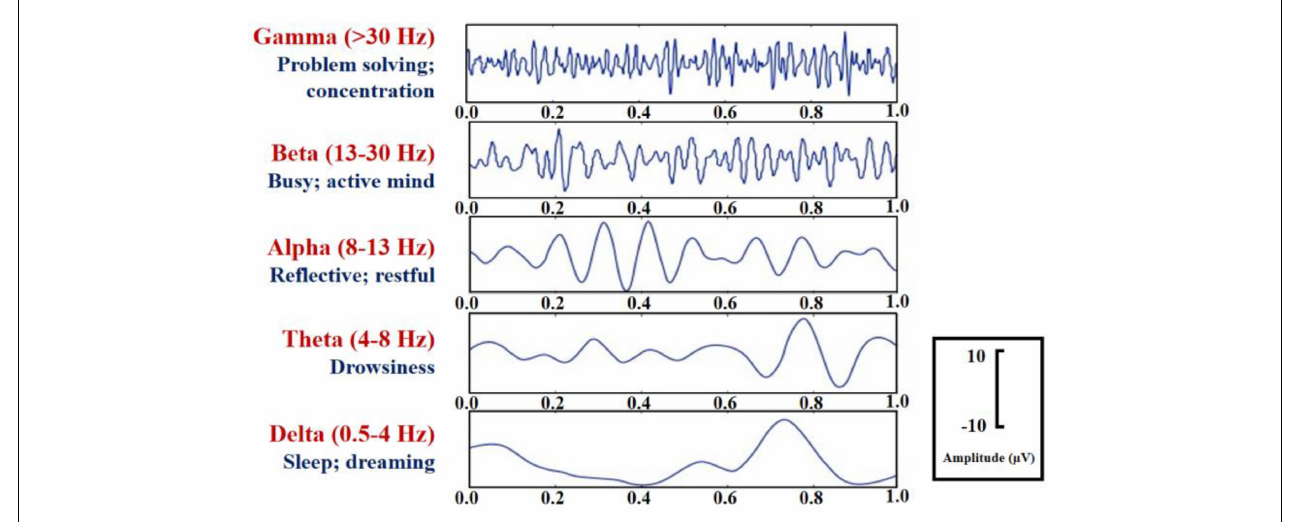
FIGURE 4 | EEG wave band